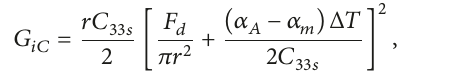
Figure 4: Coefficient of thermal expansion of epoxy resin versus temperature.